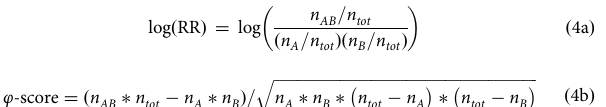
Fig. 2 Schematic representation of LeMeDISCO. a The method for determining the MOA proteins associated with a disease indication via MEDICASCY , and b The method for determining the comorbidities associated with a given disease and its molecular mechanisms via